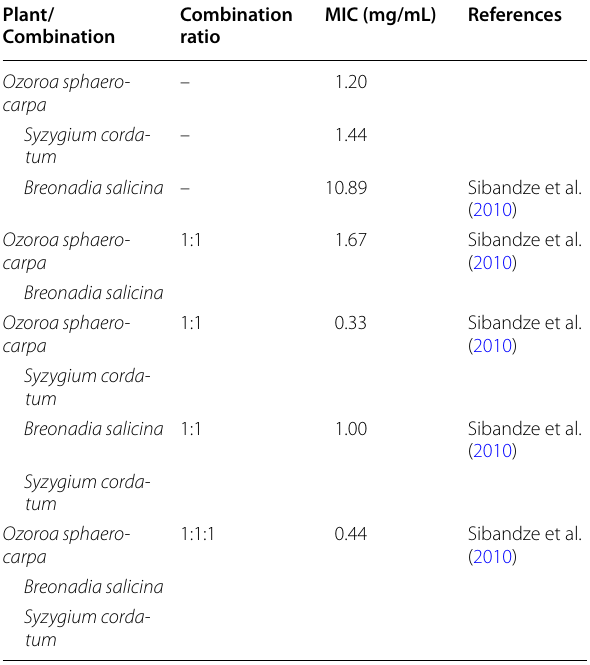
MIC minimum inhibitory concentration